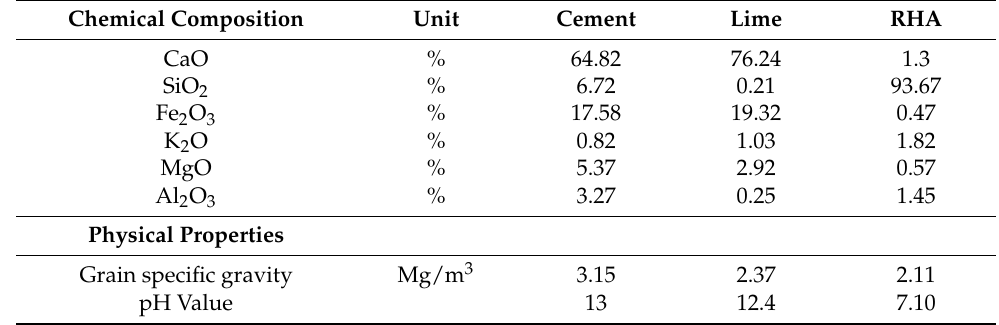
Table 2. Cement, lime, and RHA chemical